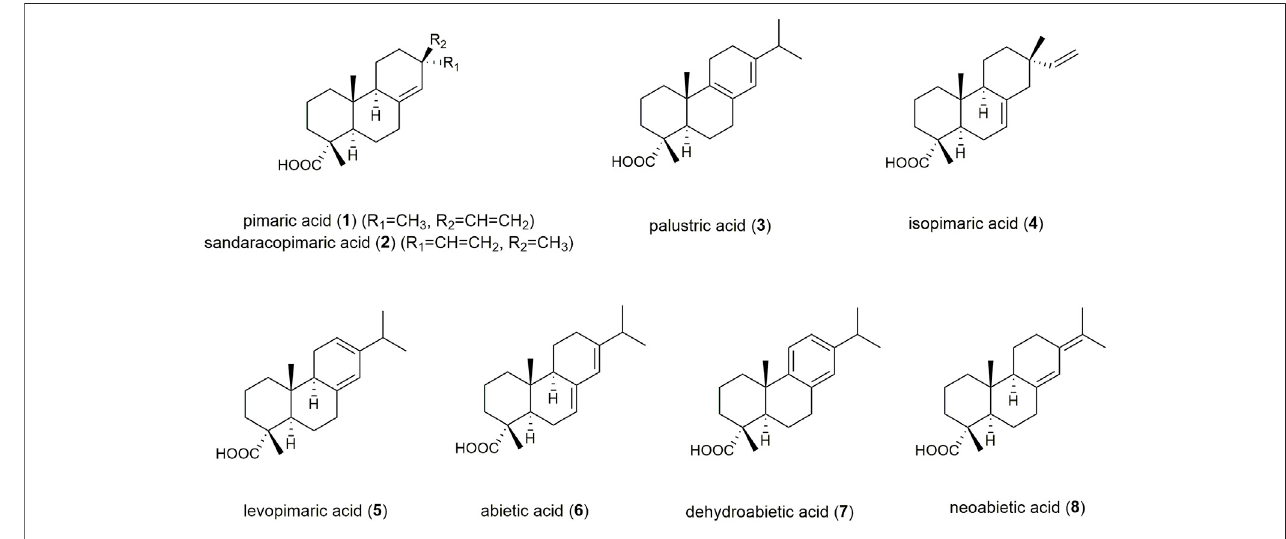
FIGURE 1 | Structures of quantitated highly similar DRA